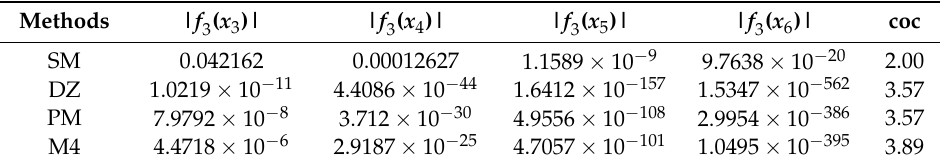
Table 3. Result of comparisons for the function f 3